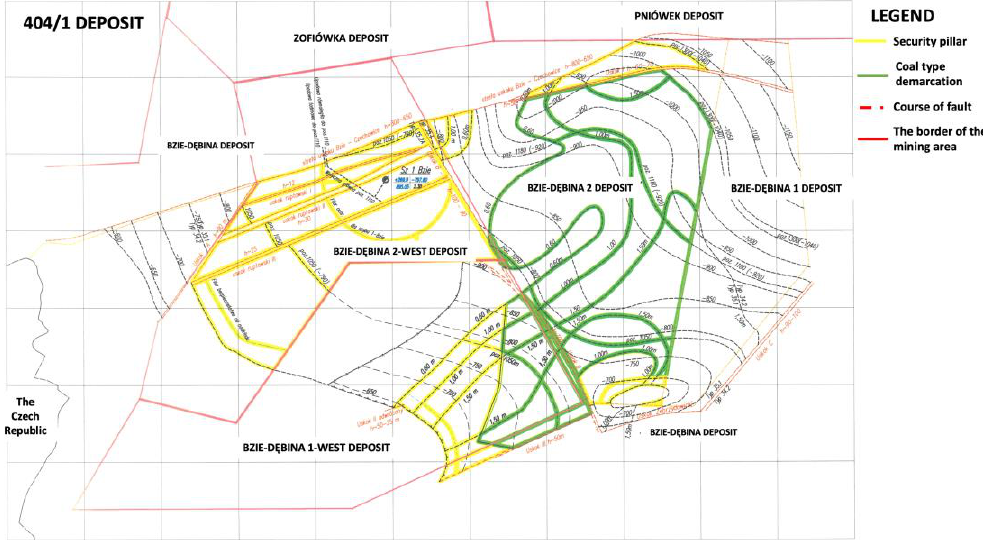
Figure 2. Map of the 404/1 coal seam.